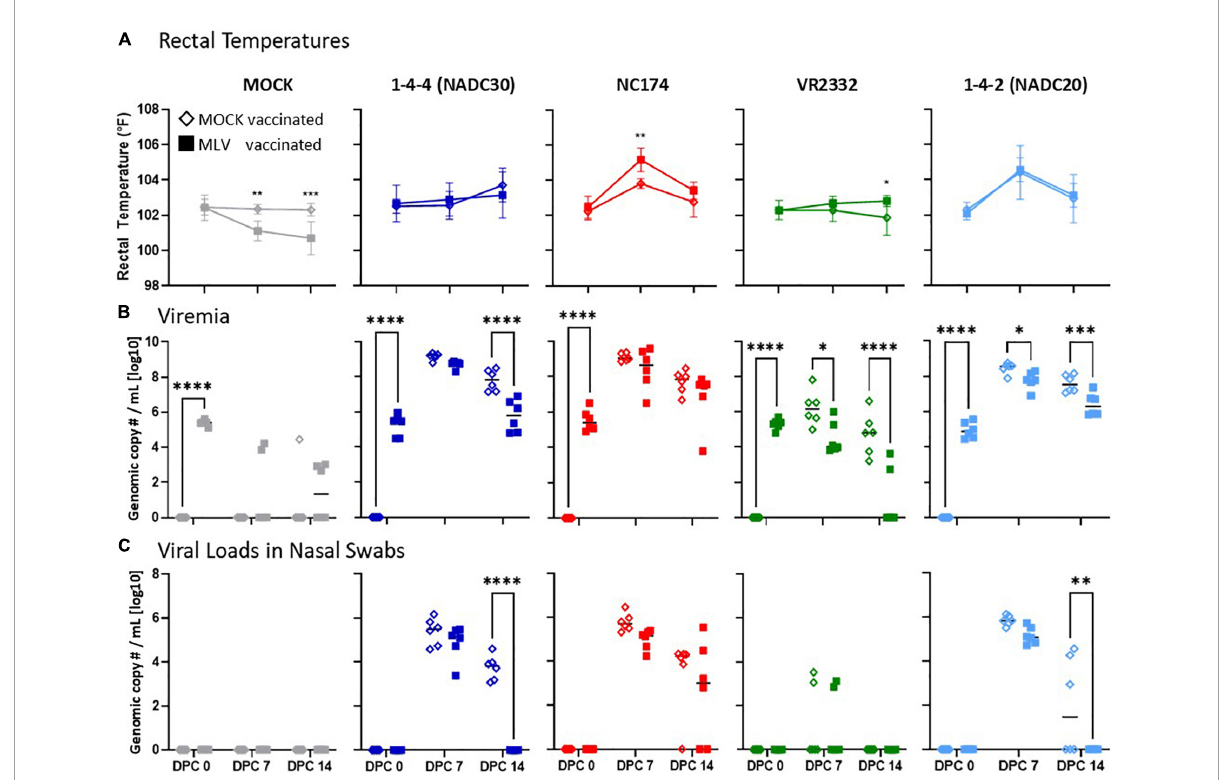
FIGURE2 Heterologous vaccine efficacy of Prevacent—rectal temperatures, viremia, and viral loads in nasal swabs. Rectal temperatures (A) , viremia (B) , and (C) viral loads in nasal swabs were determined at 0, 7, and 14 days post challenge (dpc) with MOCK (gray), or the PRRSV strains 1–4–4 (NADC30, dark blue), NC174 (red), VR2332 (green), or 1–4–2 (NADC20, light blue). The line graphs in panel (A) illustrate the means with standard deviation of rectal temperatures [ ◦ C]. Viremia (B) and viral shedding (C) were quantified by PRRSV-specific qPCR in serum and nasal swabs, respectively (genomic copy numbers/mL [log10]). The black bars represent the median values; in addition, individual data points are shown for MOCK vaccinated animals (open diamonds) and MLV vaccinated animals (filled squares). The data were analyzed using Šidák multiple comparison test 2-way ANOVA. Each vaccinated group was compared to their respective PRRSV type-2 challenge MOCK vaccinated group within each timepoint. ∗∗∗∗ p < 0.0001, ∗∗∗ p < 0.001, ∗∗ p < 0.01, ∗ p <